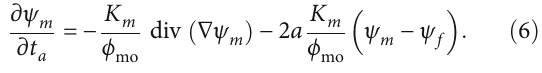
and Γ : reservoir boundary; Γ 1 2